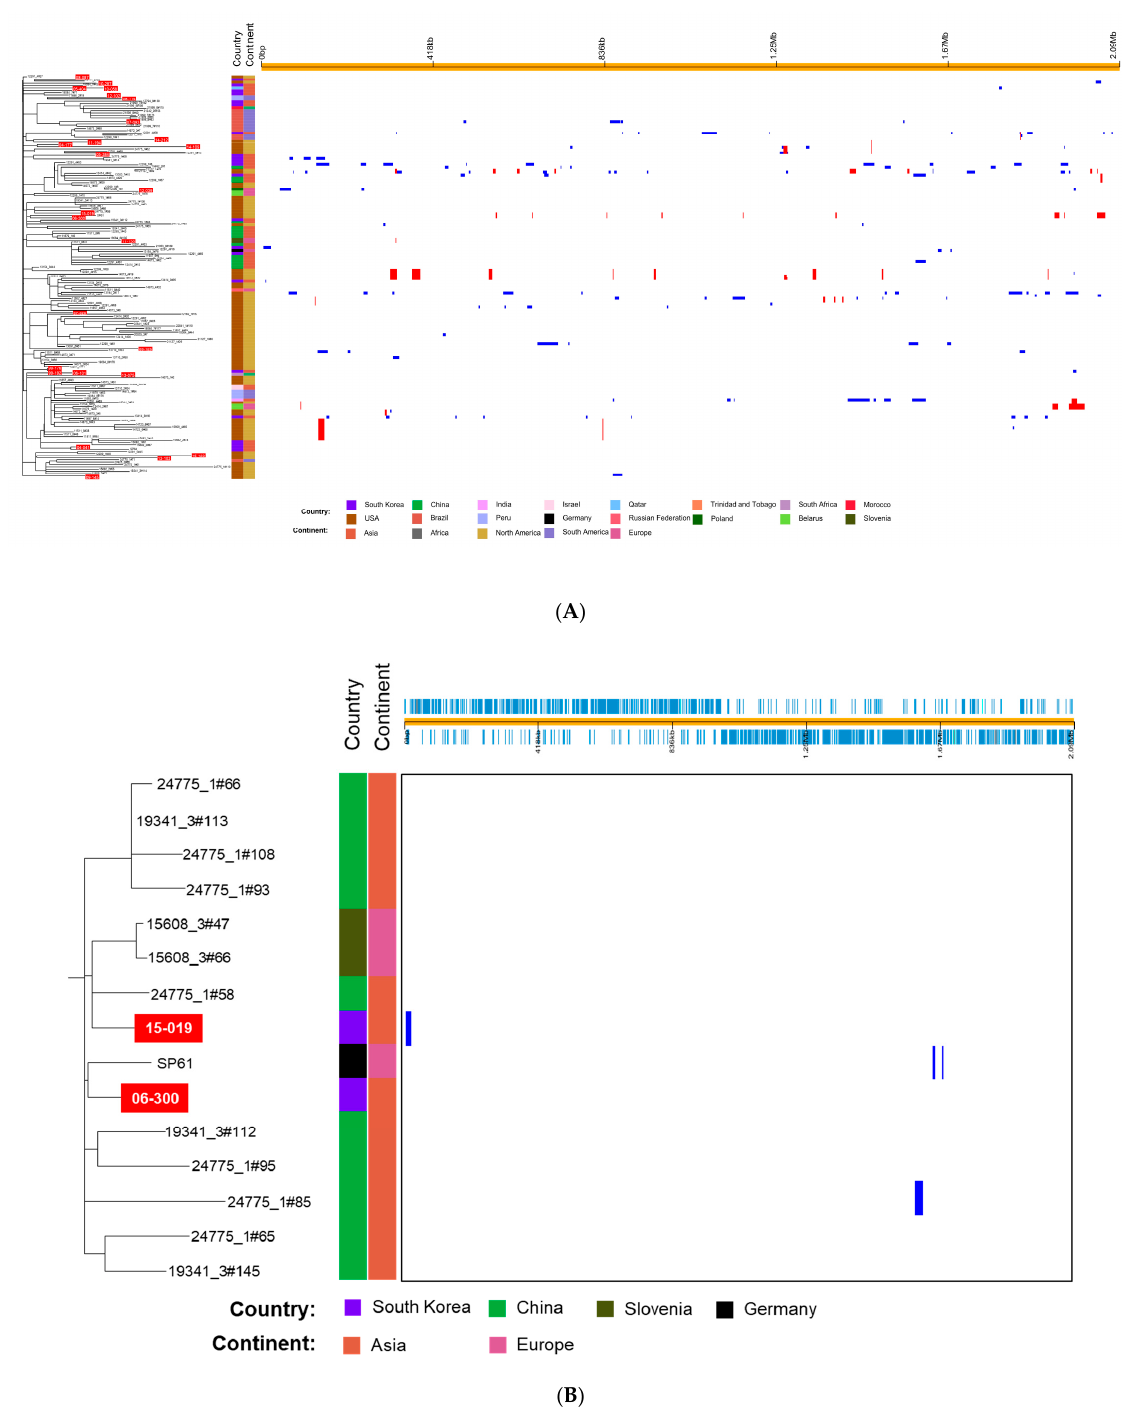
Figure 2. ( A ) Phylogenetic tree and predicted recombination sites of 179 S. pneumoniae 19A-ST320 isolates based on whole-genome sequence data of 26 isolates determined in this study. Sequences of 151 isolates were retrieved from the Global Pneumococcal Sequencing (GPS) project (https://www.pneumogen.net/gps/) (accessed on 12 February 2021) and sequences of SP61 and SP64 were obtained from Germany. On the left, the phylogenetic tree constructed via RAxML based on SNPs is shown. The isolates from South Korea are represented with a red background. On the right, recombination sites are shown. Red bars indicate that recombination is ancestral, i.e., occurred at a non-terminal nod. Blue bars are shown if they appeared in one isolate. ( B ) A sub-cluster containing S. pneumoniae isolates 15-075 and 06-300, which are represented with a red background. GPS, global pneumococcal sequencing; RAxML, Randomized Axelerated Maximum Likelihood; SNPs, single nucleotide